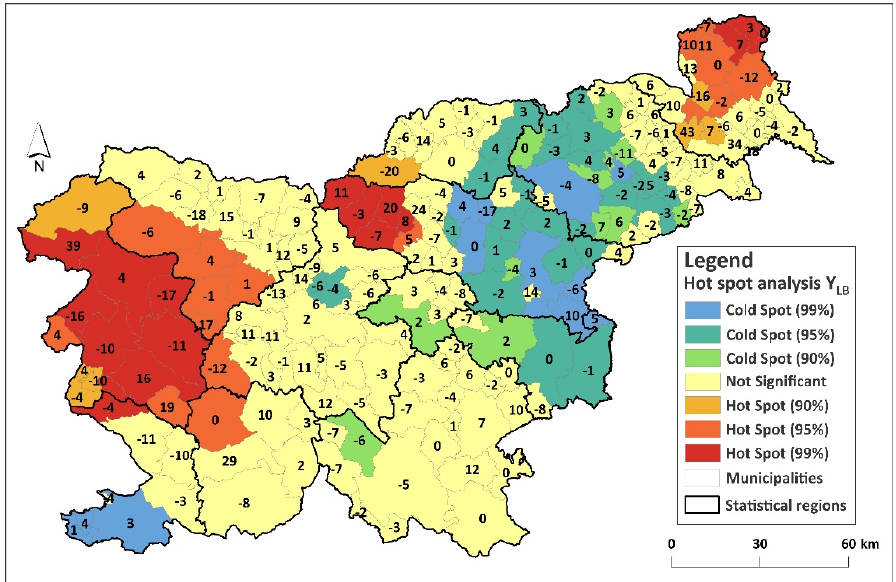
Figure 3. MGWR model predicted LB hot and cold spots. The numbers represent the deviations (residuals) of the predicted Y LB from the actual Y LB